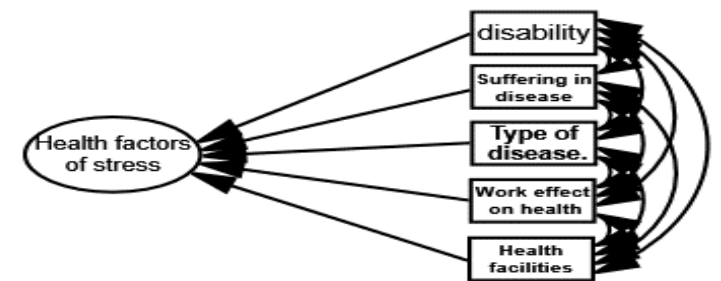
Mathematics 2020 , 8 , x FOR PEER REVIEW Figure 10. Hypothetical model of health factors. Figure 10. Hypothetical model of health factors. Figure 10. Hypothetical model of health factors.